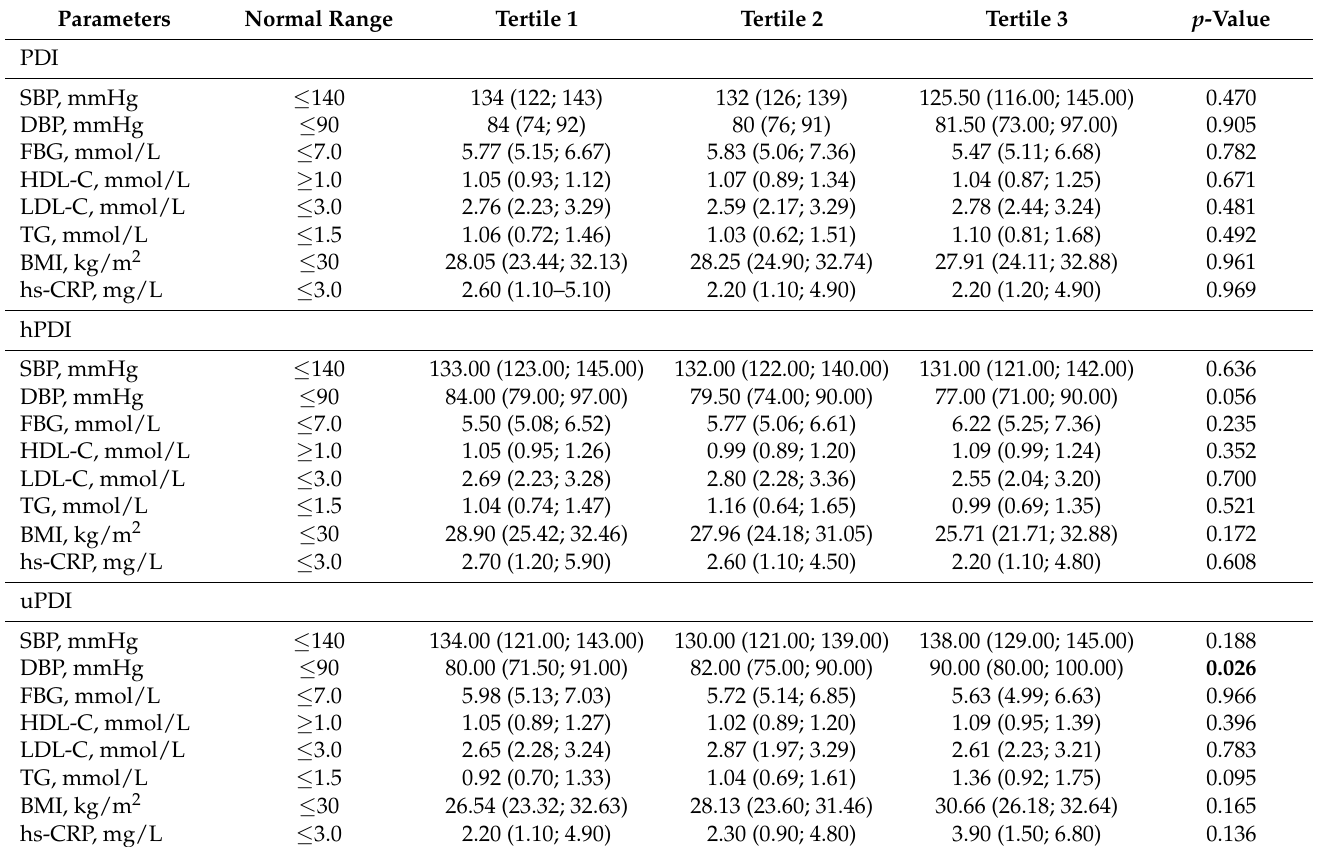
Table 4. Cardiometabolic risk profiles of the PBD